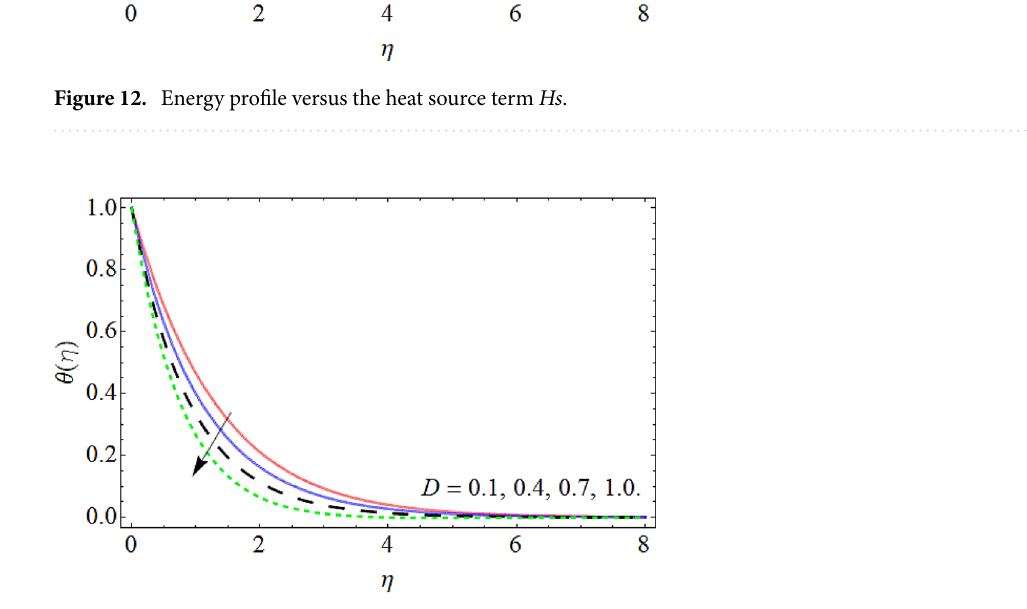
Figure 13. Energy profile versus the local Deborah number D